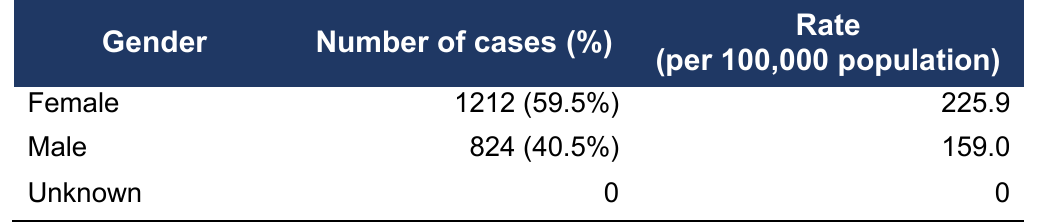
Table 1. Ottawa residents with confirmed COVID-19 (n=2,036), by gender